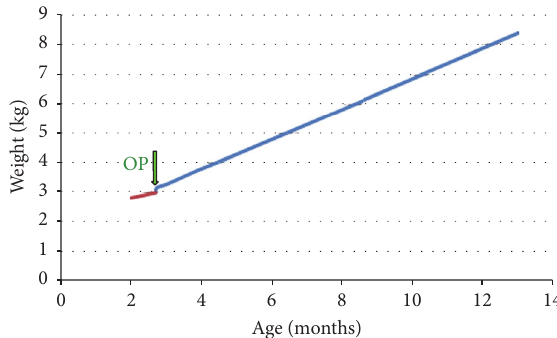
Figure 9: Weight development in patient 2 suffering from complex congenital malformation syndrome, respiratory insufficiency with ventilator dependency, recurrent aspirations, cerebral palsy, and epilepsy.